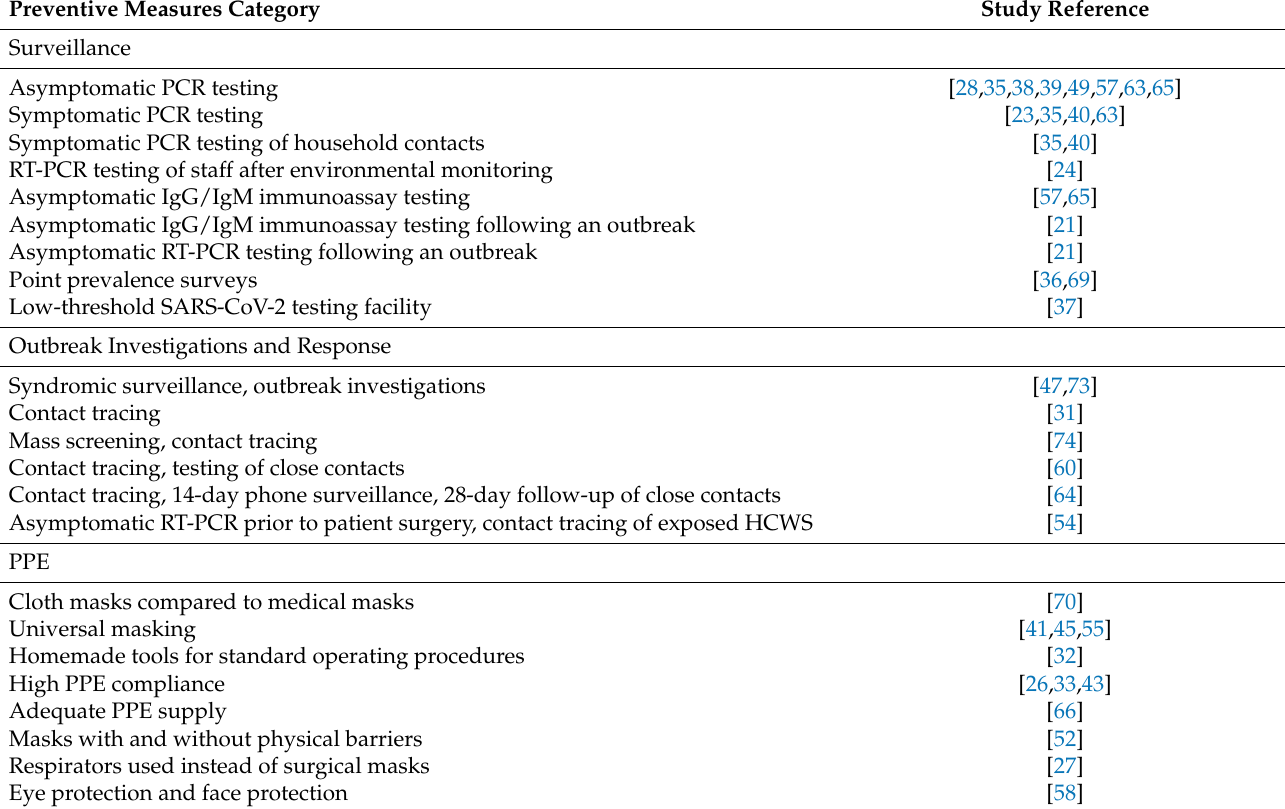
Table 4. Map of single workplace COVID-19 measures implemented by